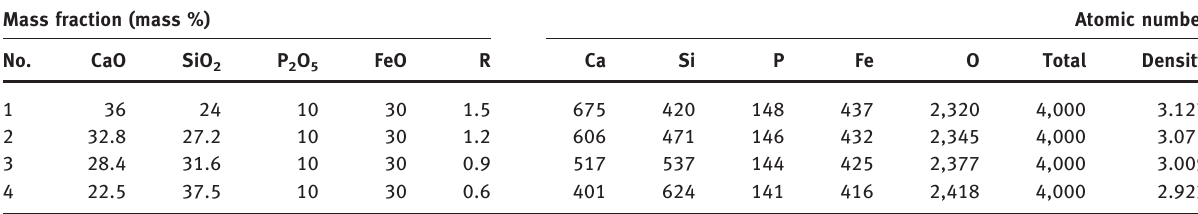
Table 2: Slag compositions and number of molecules used in the MD simulation. Mass fraction (mass %) Atomic number